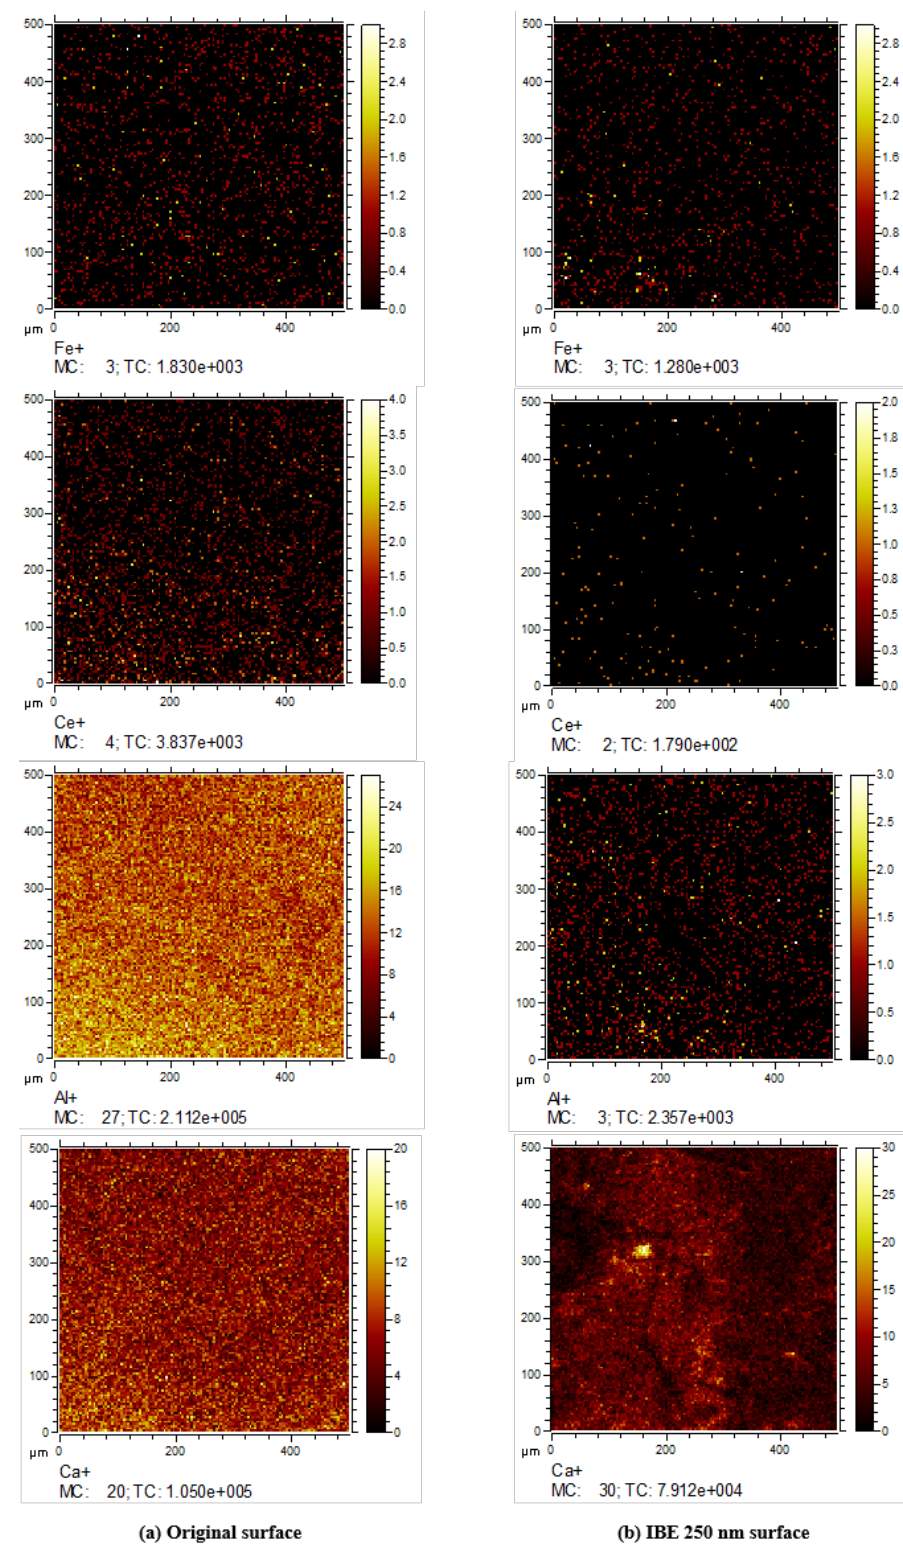
Figure 2. The concentration distribution of metal impurities detected by TOF-SIMS. ( a ) Original surface: the surface is enriched in Fe, Ce, Al and Ca element; ( b ) Ion beam etching (IBE) 250 nm surface: The concentration distributions of Ce, Al, and Ca become sparse. However, the concentration distribution of Fe changes little, and some bright spots are enriched in the Ca element.